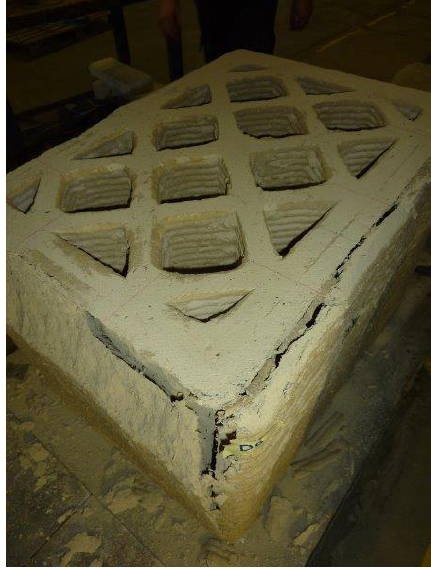
Figure 23. Appearance of the specimen after raising the head of the testing machine.